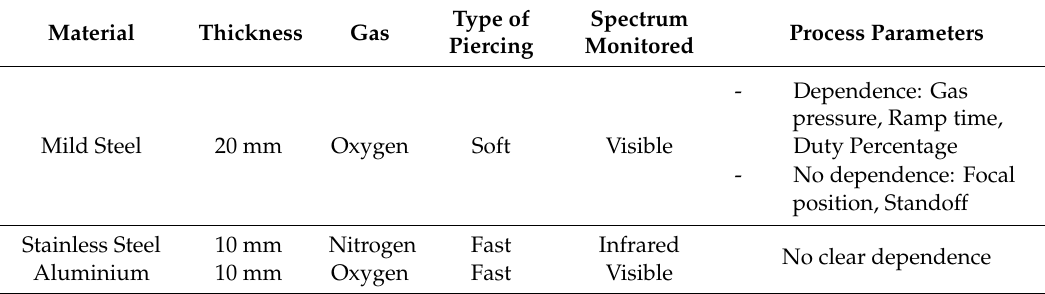
Figure 5. Piercing monitored signal for aluminum 10 mm thick, varying ( a ) focal position; ( b ) duties percentage. Focal positions of 1.5 or 2.5 and duties percentages of 25 25 and 22 22 provoked explosions. Table 2. Resume of monitored experiments and dependence of process parameters.